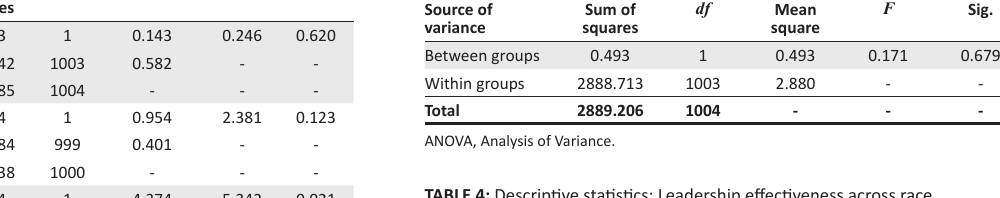
Std. error deviation